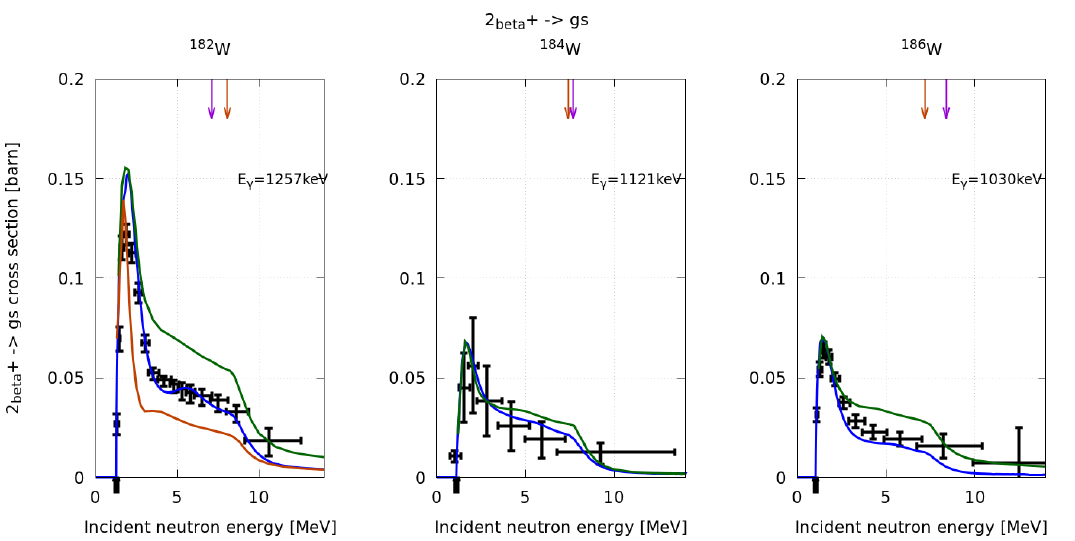
to g.s. . No data could be extracted from the nat W beta